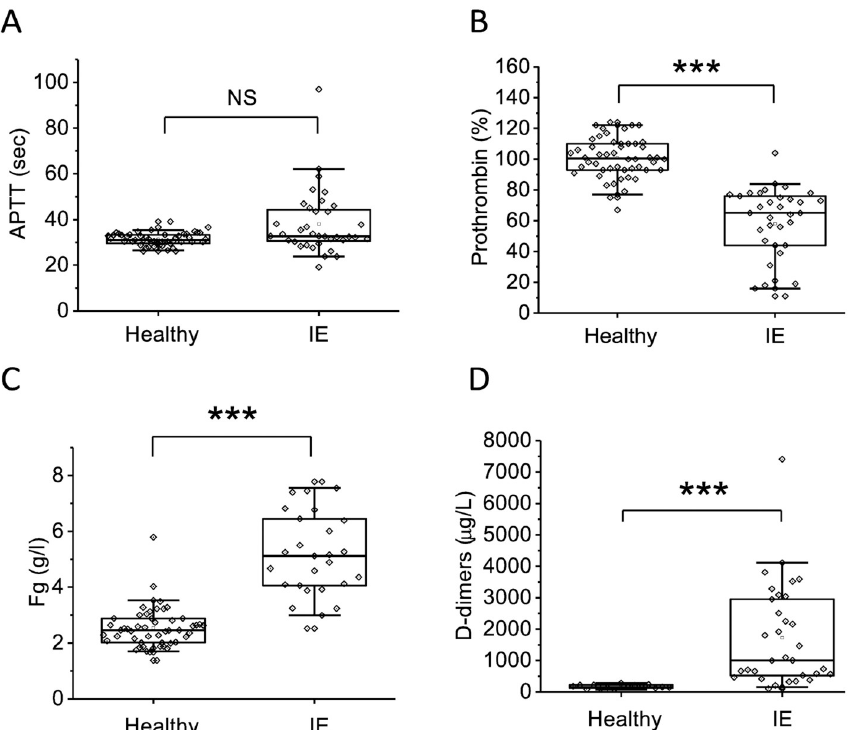
Fig 1. Parameters of routine coagulation tests in IE patients and healthy volunteers at admission. A—APTT (sec), B—prothrombin (%), C—fibrinogen (g/l), D—D-dimers ( μ g/l). The box plots indicate the following parameters: the mean value (the dot inside the box), the median (the horizontal line inside the box), the 25 th and 75 th percentiles (the bottom and top of the box, respectively) and 5 th and 95 th percentiles (the ends of the whiskers). Groups were compared according to Mann-Whitney test; � p < 0.05, �� p < 0.01, ��� p < 0.001, NS—not